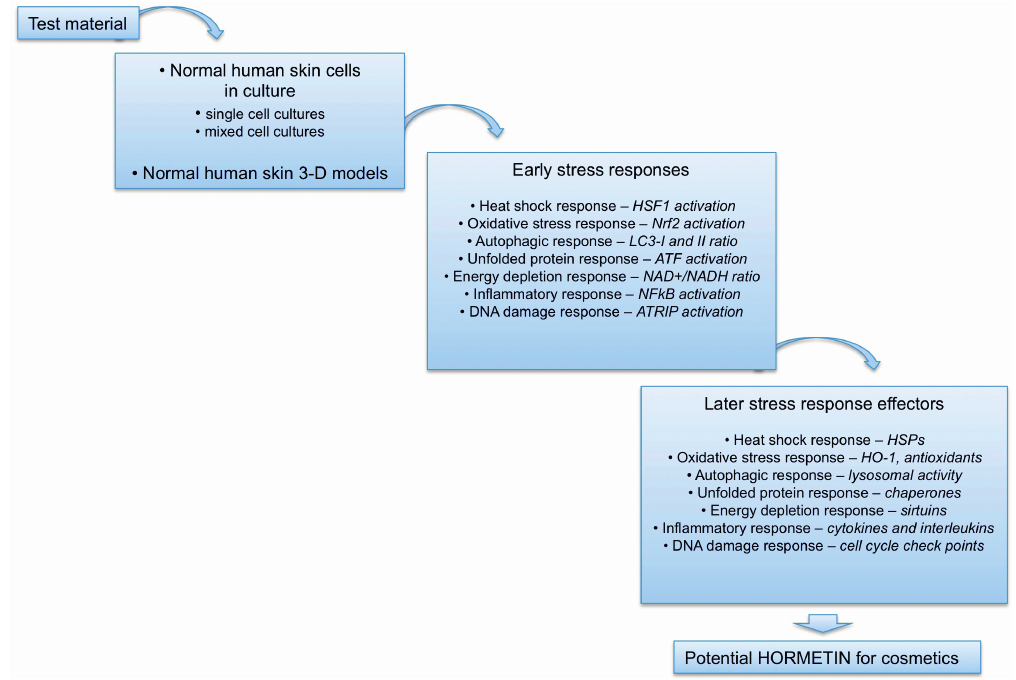
Figure 2. A scheme for the screening of potential hormetins for cosmecuticals by analyzing the immediate stress response markers and late effector molecules for the maintenance and repair in cell cultures and 3D skin